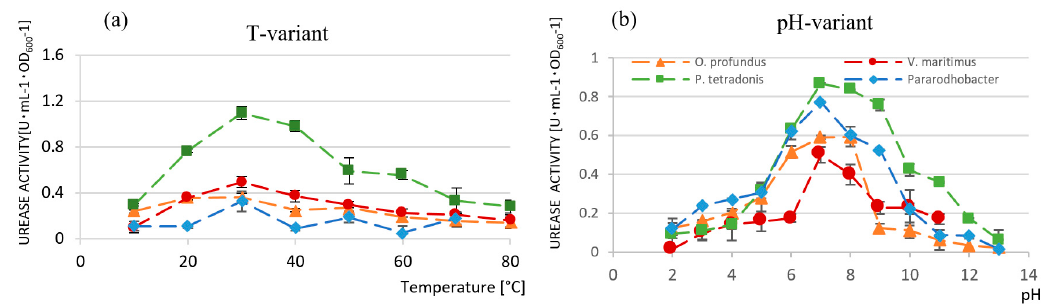
Figure 6. ( a ) Effect of reaction temperature on urease activity of the whole cell at pH 7 (1 mM EDTA- disodium salt solution); ( b ) Effect of reaction pH on urease activity of the whole cell at 37 °C 1 mM EDTA-disodium salt solution); ( b ) E ff ect of reaction pH on urease activity of the whole cell at 37 ◦ EDTA-disodium salt solution.